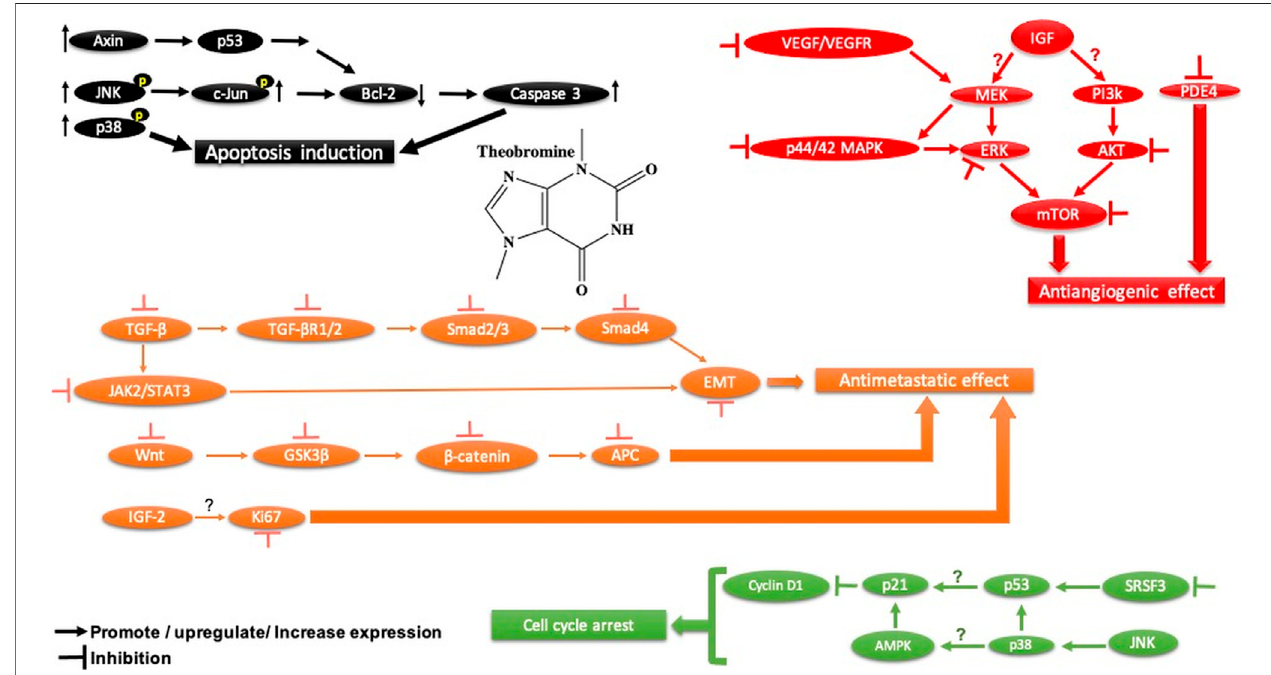
FIGURE 8 | Main mechanism of theobromine against